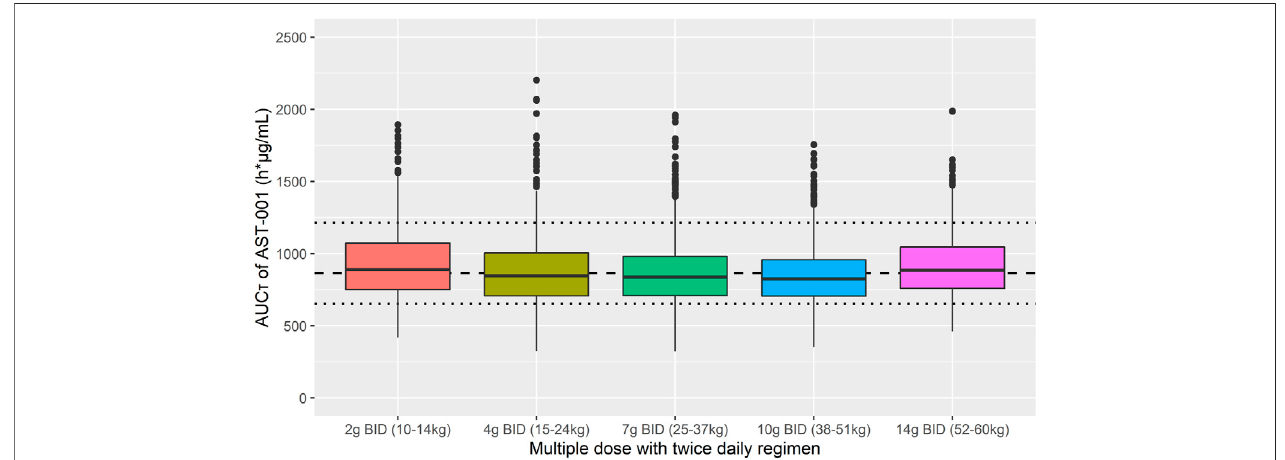
FIGURE5| SimulationresultsofAUC τ after7-daystwice-dailymultipleadministrationof2 g,4 g,7 g,10 g,and14 gin10 – 14 kg,15 – 24 kg,25 – 37 kg,38 – 51 kg, and 52 – 60 kg weight ranges, respectively. Short dashed line represents the median observed value after 7-days twice daily multiple doses of 15 g AST-001 in healthy subjects. Dotted line represents the corresponding minimum and maximum observed values. The dots are outliers in the simulation that exceed the 25 th and 75 th quartile range.